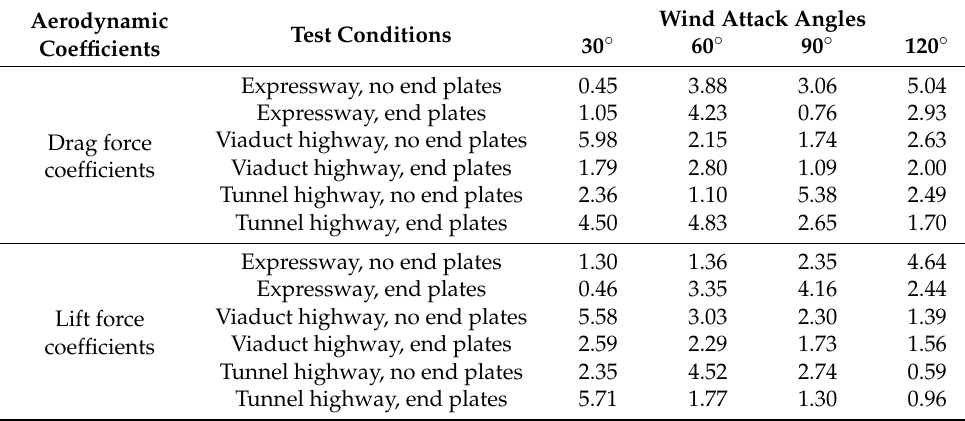
Table 5. Three times repeatability precision ( × 10 − 2 ) of aerodynamic coefficients from transiting tests conducted.